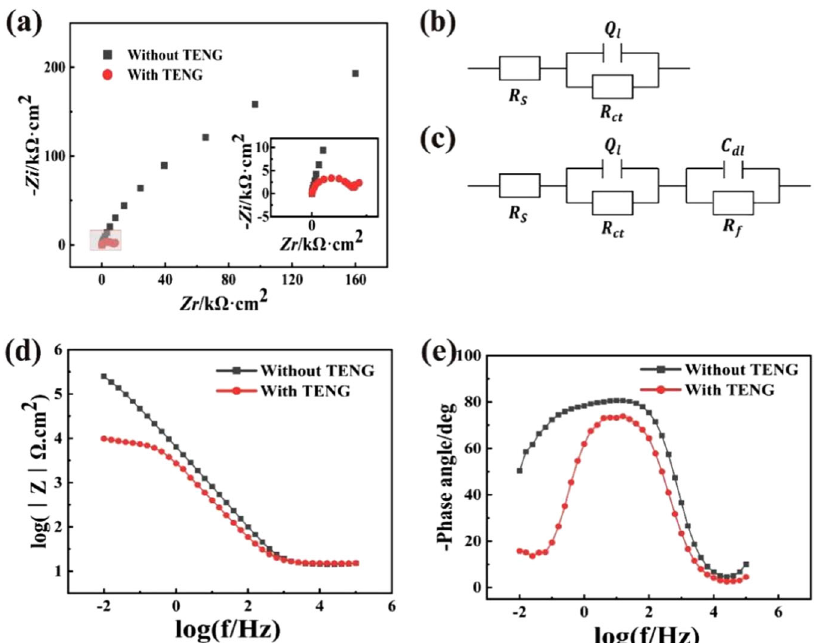
Fig. 5 The EIS of 304SS. a Nyquist curves of 304SS with and without cathodic protection powered by the S-TENG. b The equivalent circuit of 304SS connected without the S-TENG and ( c ) the equivalent circuit of 304SS connected with the S-TENG. d Impedance-frequency Bode plots and ( e ) Phase-frequency Bode plots of 304SS with and without cathodic protection powered by the S-TENG. Table 1. Electrochemical parameters obtained from Tafel curves of 304SS connected with and without the S-TENG. j corr / μ A b a /mV b c /mV Sample E corr / V (vs.SCE) cm − 2 dec − 1 dec − 1 Without TENG − 0.23 With